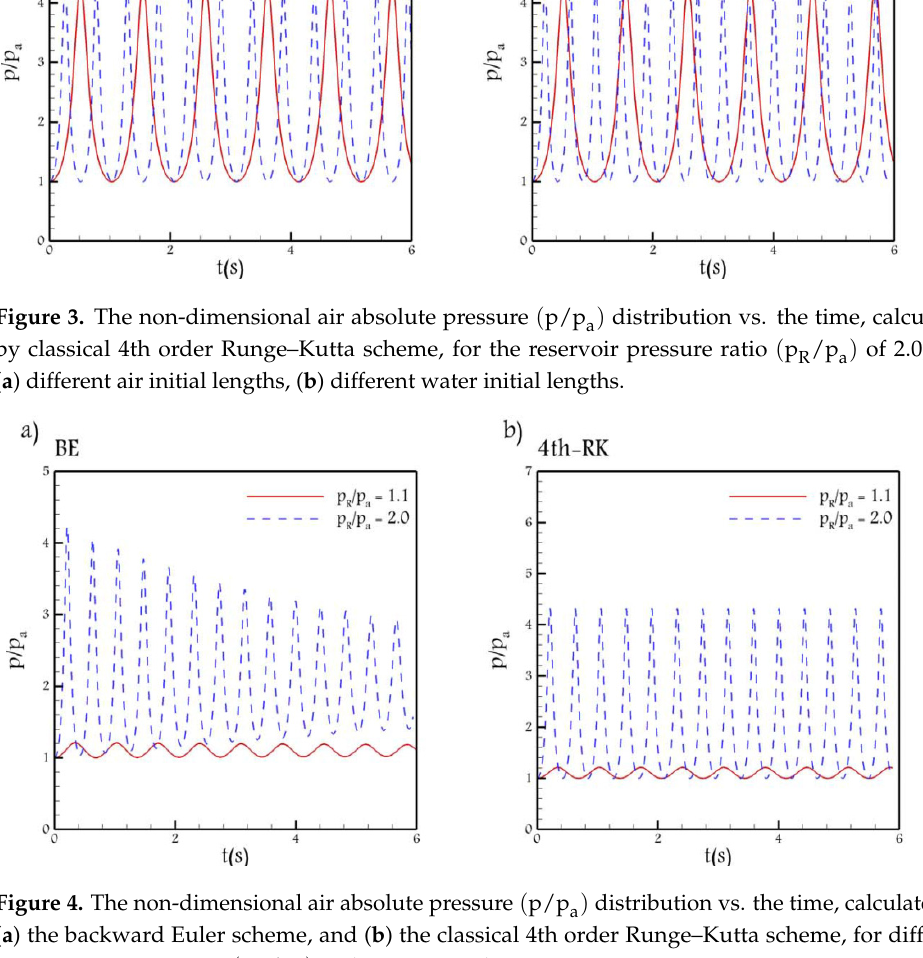
Figure 4. The non-dimensional air absolute pressure (p p (cid:2911) ⁄ ) distribution vs. the time, calculated by ( a ) the backward Euler scheme, and ( b ) the classical 4th order Runge–Kutta scheme, for differ- ent reservoir pressure ratio (p (cid:2902) p (cid:2911) ⁄ ) and L (cid:2911) = 2.0 and L = 1.0 m